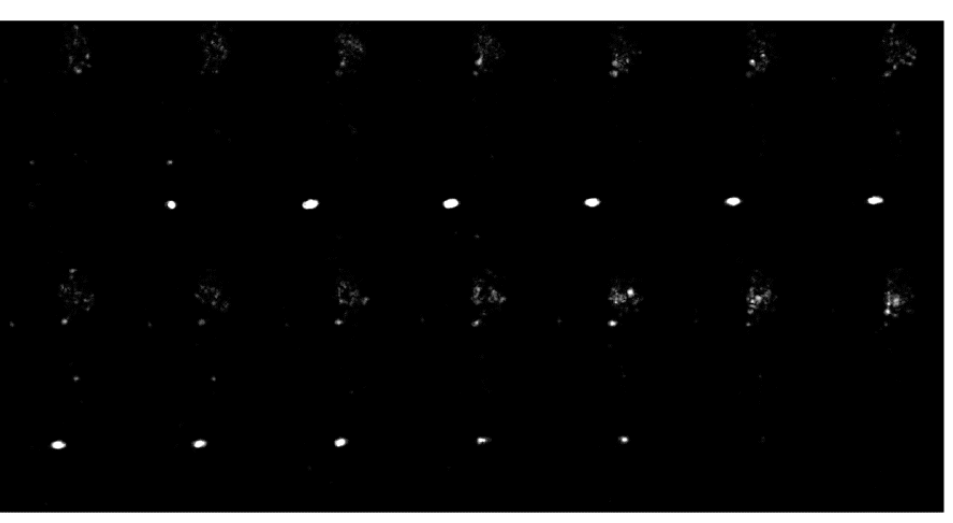
Figure 7. Scenario 33–14 threshold distribution histogram, indicating the most frequent pixel in- tensity thresholds of 17 and 18.